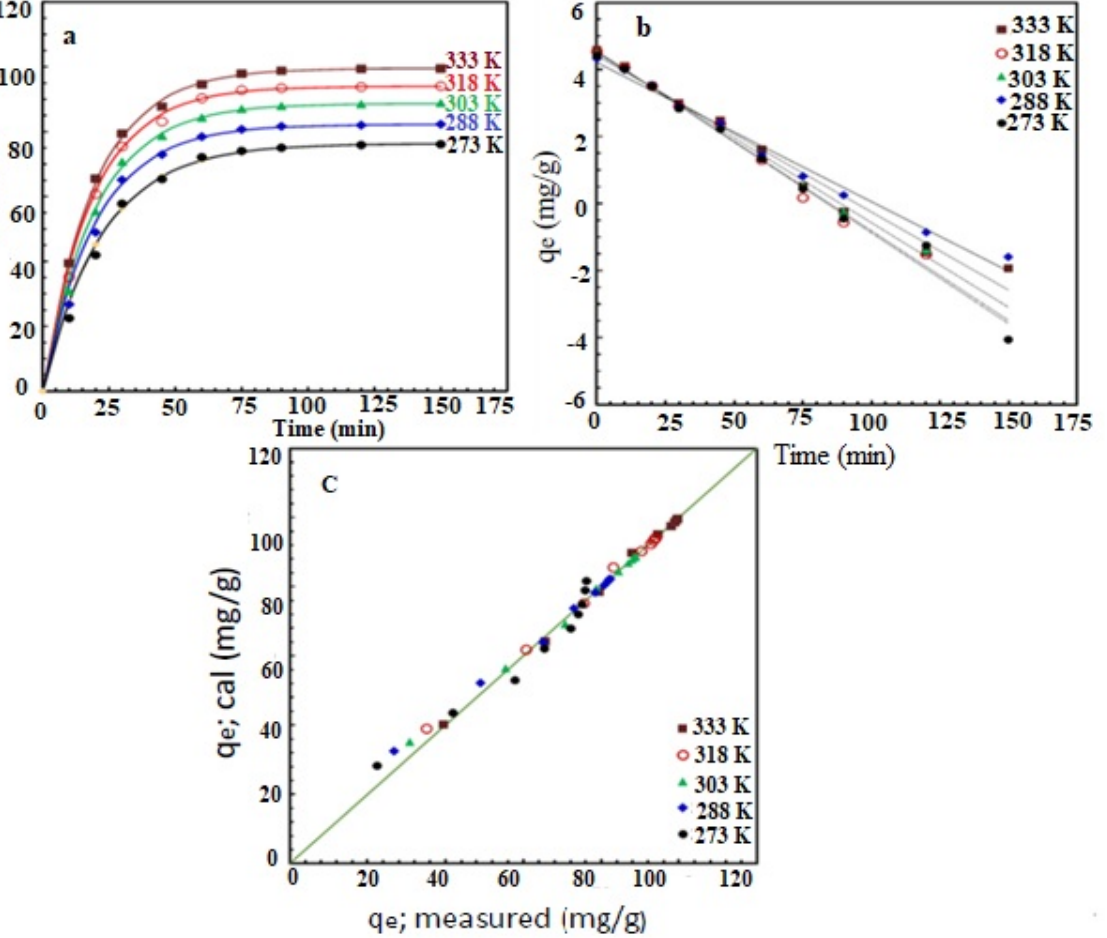
Figure 6. The adsorption kinetics for the adsorption of AZM on AFAC at various temperatures. ( a ) qe vs. time, the Symbols represent the experimental results, and the curves represent the pseudo-first-order model fitting, ( b ) the linearized (integral form) of the pseudo-first-order model, and ( c ) the model calculated adsorption capacity vs. the experimentally measured adsorption capacity shown the excellent agreement as the data points are on, or very close to, the 45 ◦ line. Conditions: pH = 9, C 0 = 100 mg/L, and dose = 1 g/L. Table 4. Analysis of the kinetics of the adsorption of AZM on AFAC using different kinetic models. Pseudo-First-Order